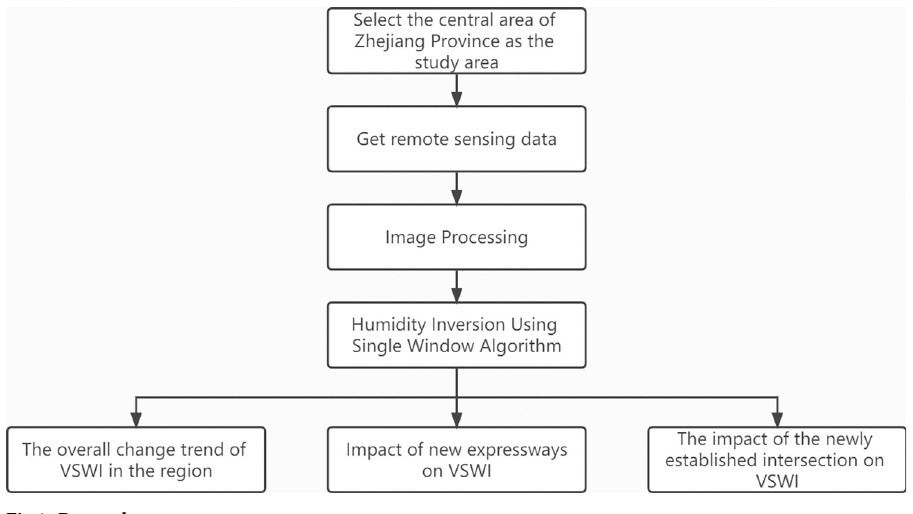
Fig 1. Research process.